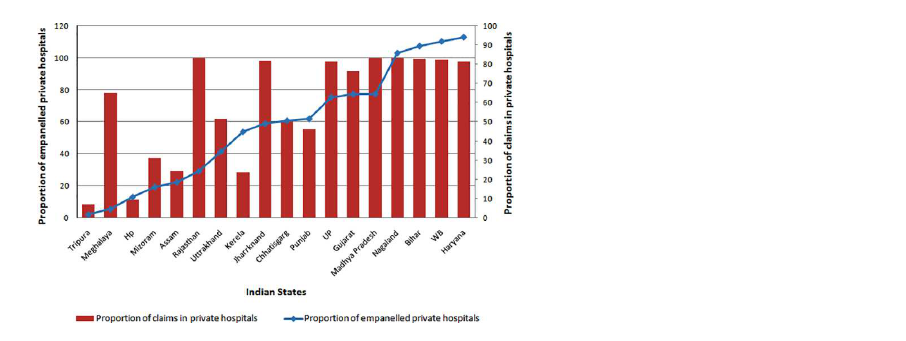
Fig 3. Correlation between private sector claims and density of private empanelled hospitals in the states across